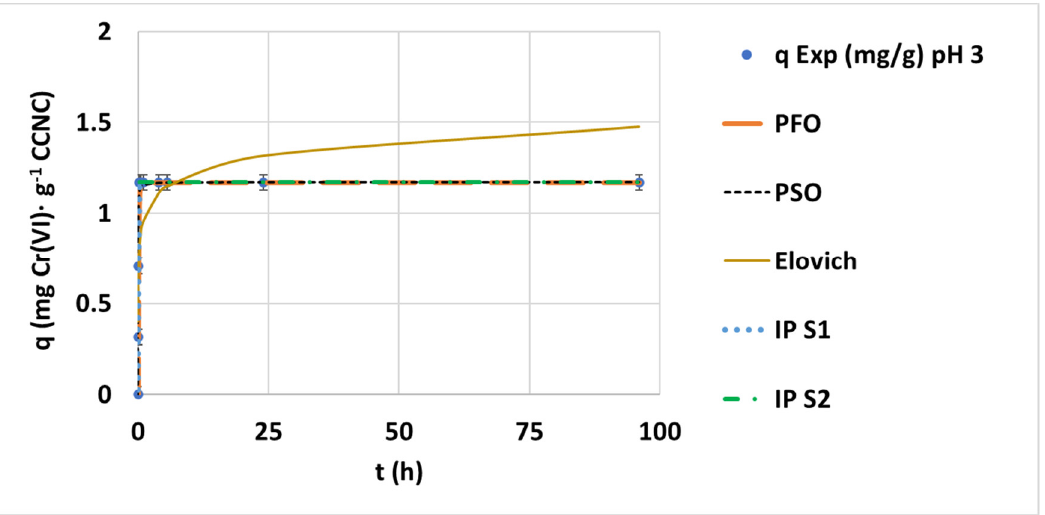
Figure 3. Evolution of the kinetic adsorption capacities at 0.1 mg·L −1 of initial chromium concentration, 100 mg·L −1 of CCNC dosage and room temperature under pH 3 conditions and the kinetic fitting of the PFO, PSO, Elovich and IP models.